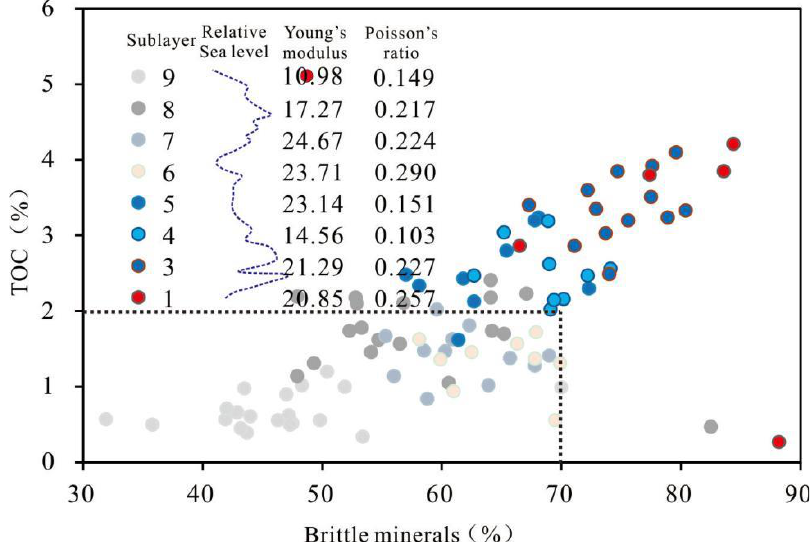
Figure 8. Relationship between TOC, brittle mineral content, and sedimentary environment.